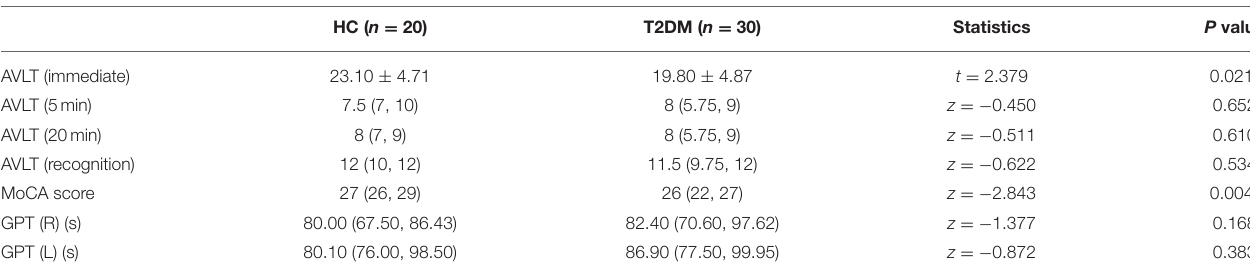
TABLE 2 | Neuropsychological result of all